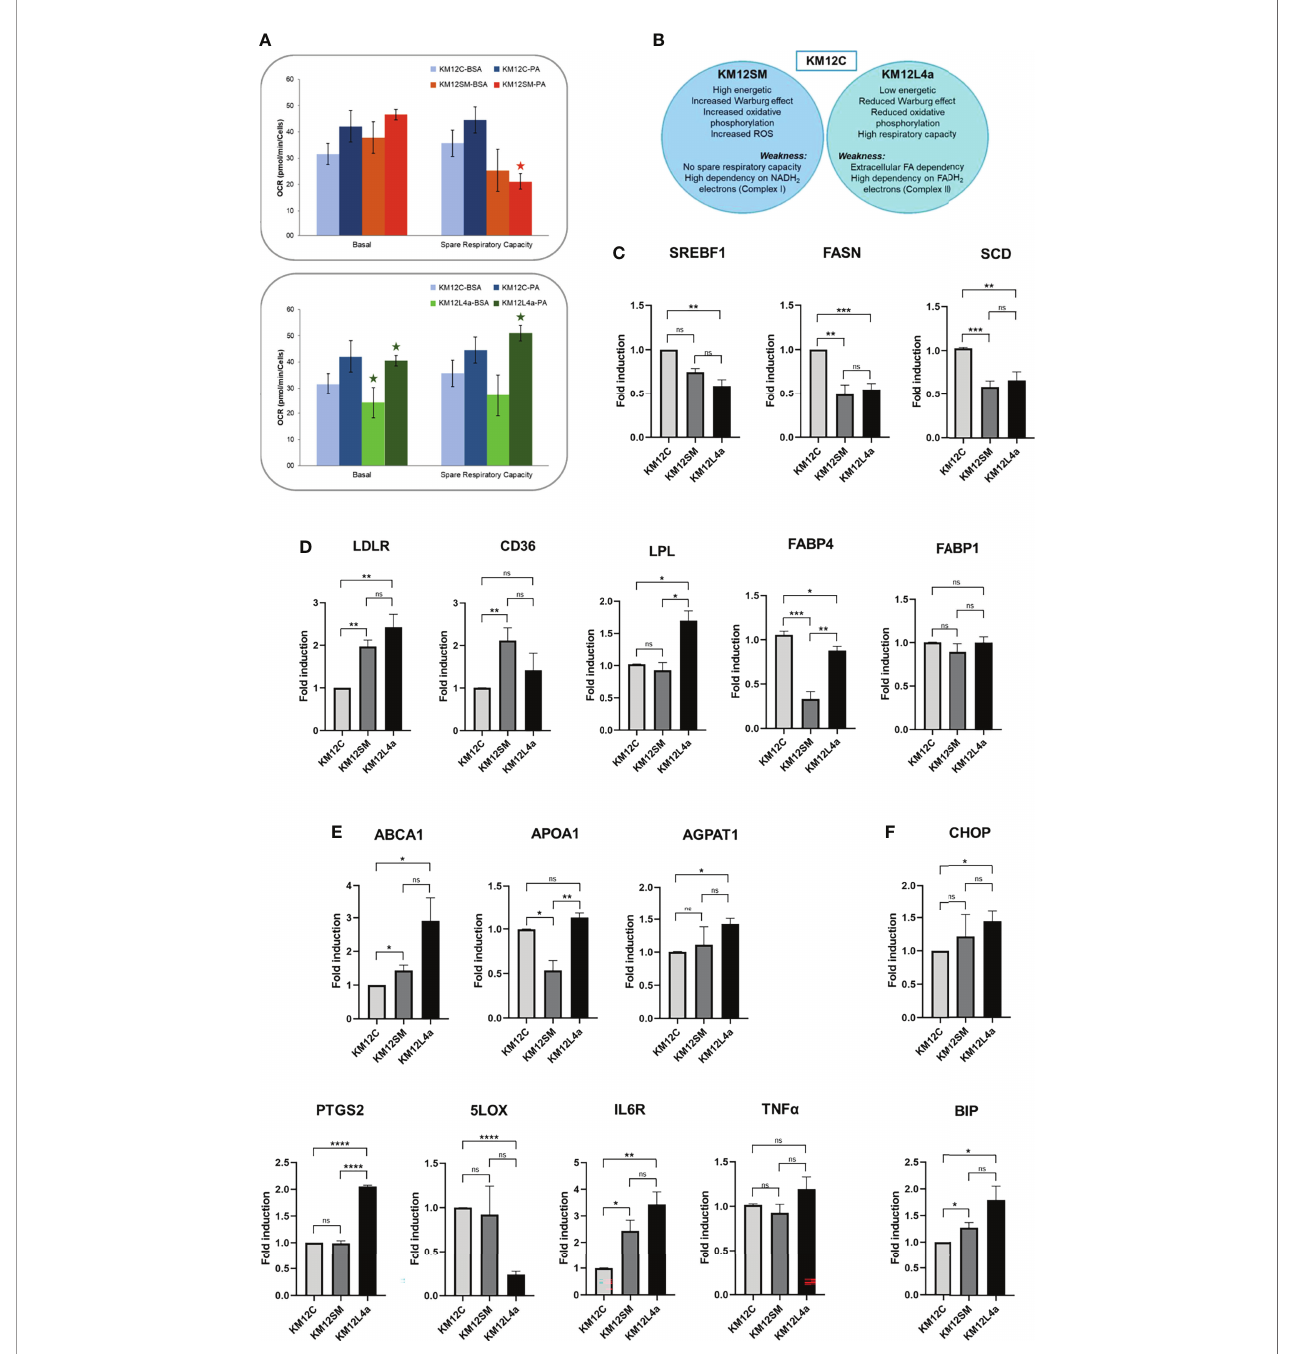
FIGURE 6 | Analysis of the expression levels of lipid metabolism genes in KM12C and KM12SM and KM12L4a. (A) Exogenous uptake of FAs and cholesterol. The mitochondrial oxidative phosphorylation response to FA supplementation was analysed with the Seahorse bioanalyzer. (B) Schematic of the strengths and weaknesses of the metastatic isogenic KM12SM and KM12L4a cells as observed from the analyses. qPCR analysis of the expression levels of lipid metabolism genes related to (C) de novo synthesis of FA, (D) intracellular cholesterol homeostasis and plasmatic membrane lipid remodeling-related genes, (E) cholesterol and membrane lipid remodeling and of lipid metabolism-related in fl ammatory markers, and (F) cellular stress mediators in KM12SM and KM12L4a referring to KM12C parental cells. * p value < 0.05; ** p value < 0.01; *** p value < 0.001; **** p value <